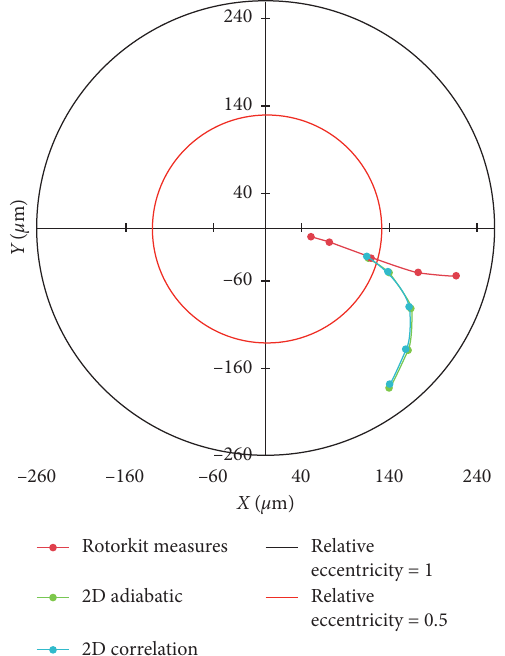
Figure 9: Journal center locations for the original RK.